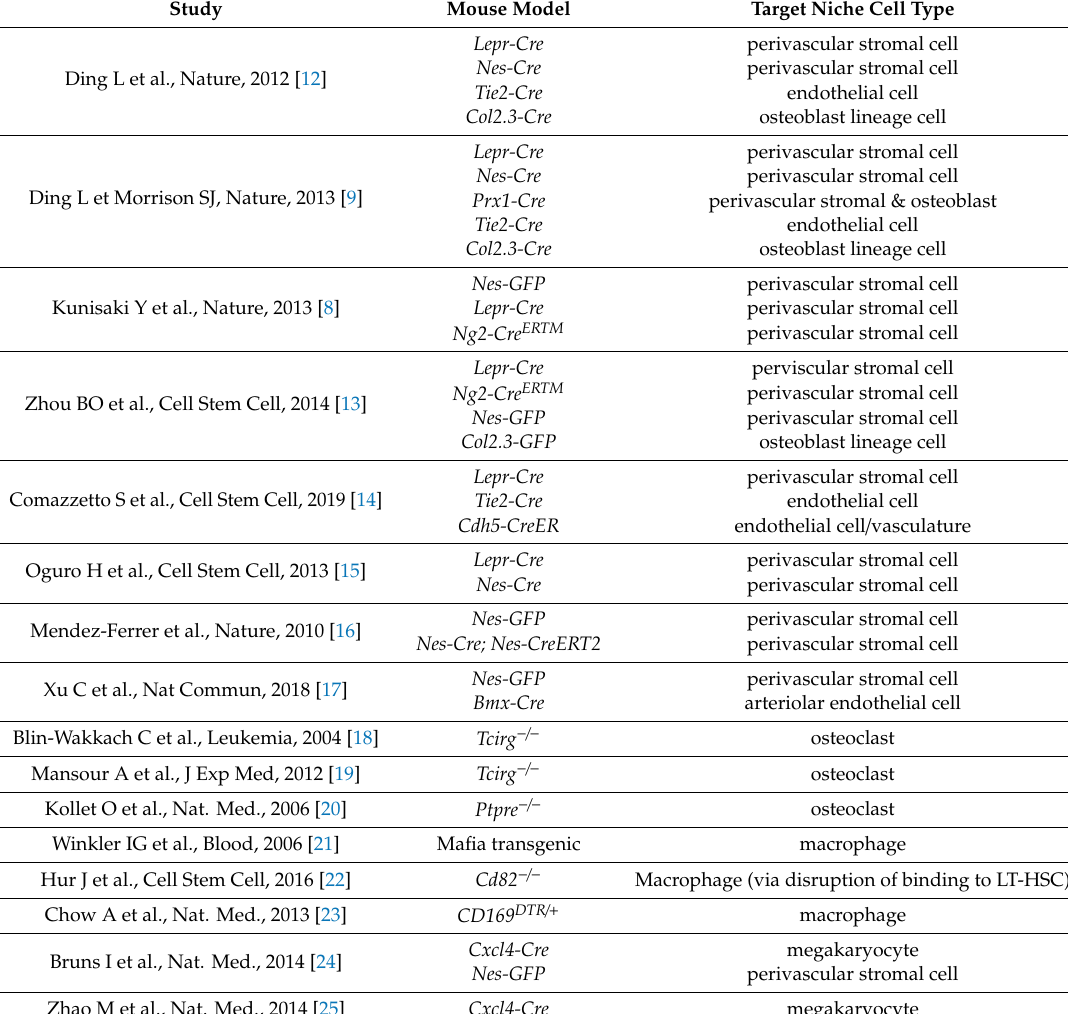
Table 1. Selection of studies using landmark mouse models for functional characterization of BM niche